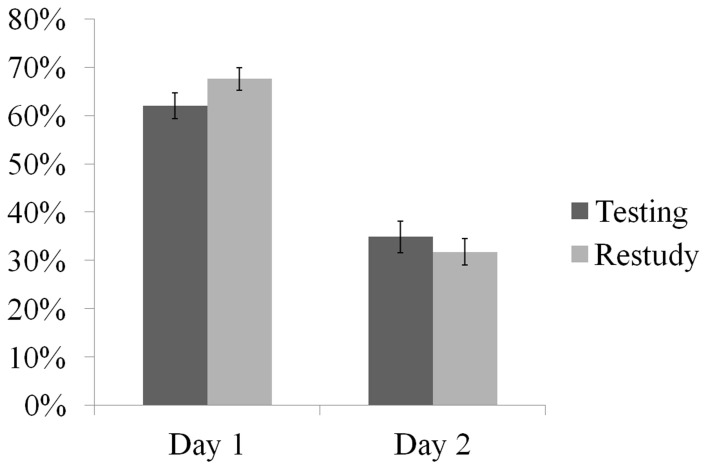
Percent correct for tested and restudied items at cued recall on Day 1 and at final recall on Day 2. Error bars show 1 ± standard error mean.